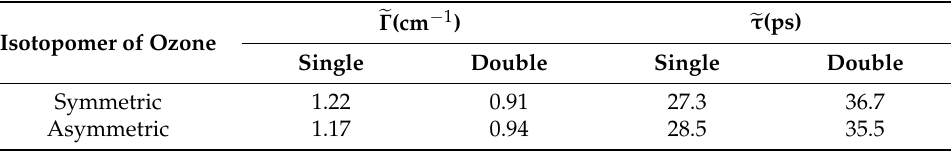
Table 3. Average resonance widths and their corresponding lifetimes for the resonances localized in the covalent well of symmetric and asymmetric ozone molecules for the cases of single and double isotopic